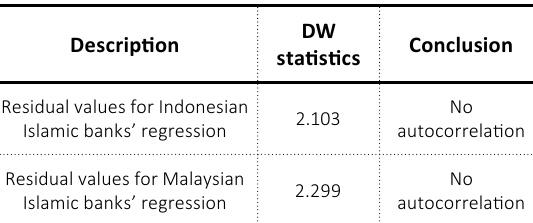
Table 7. Durbin-Watson test results